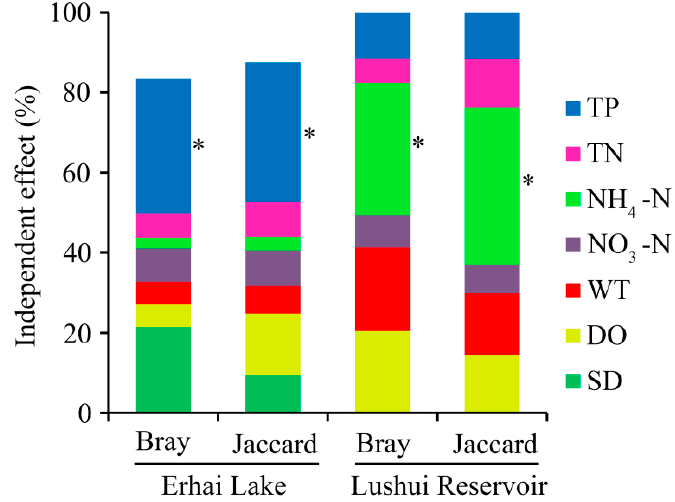
Figure 5. Independent e ff ects of environmental factors on community dissimilarity as estimated from hierarchical partitioning. Asterisks indicate significant e ff ects ( p < 0.05, randomization test). SD values for the Lushui Reservoir were not available.